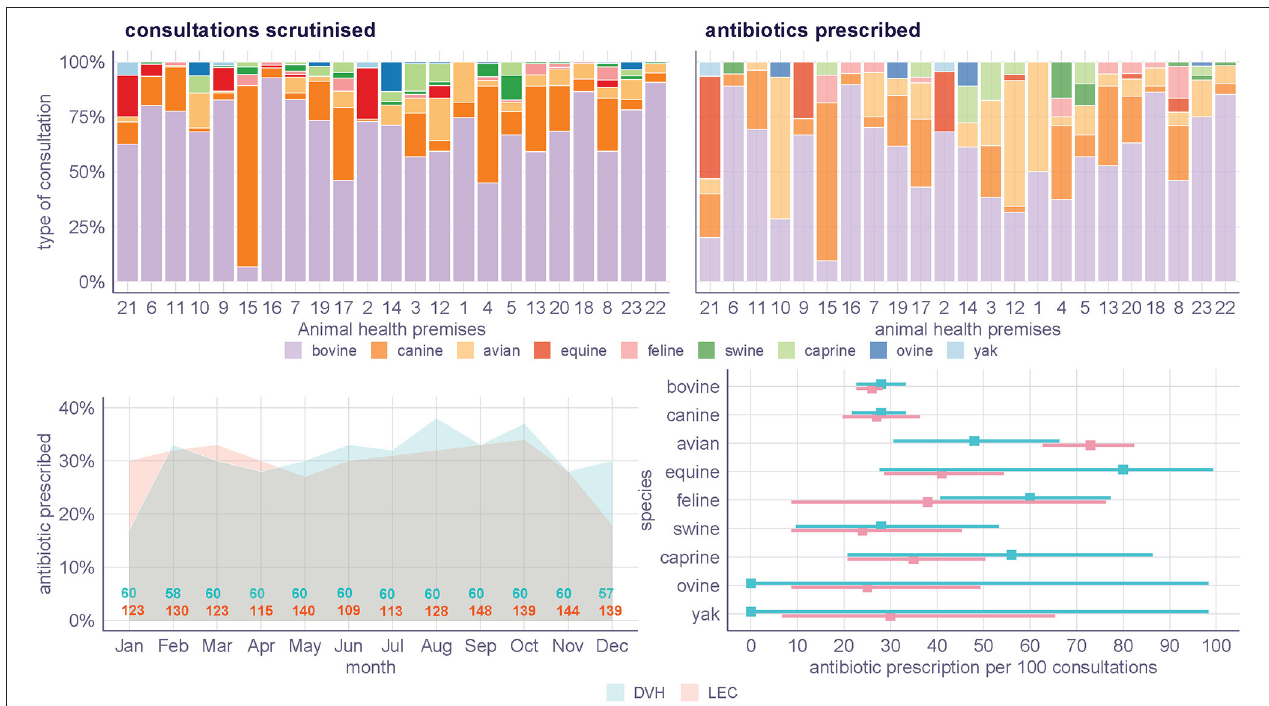
FIGURE 3 | Post-hoc analyses. Top, distribution of consultations per AHP (left) and distribution of consultations that resulted in at least one antibiotic prescribed (right, faded). Bottom: distribution of prescription across 2017 and the total number of records that inform each month (left). Incidence of antibiotic prescription (and 95% confidence interval) expressed as the number of veterinary consultations that resulted in an antibiotic prescription per 100 consultations in 2017 (right). LEC, livestock extension center; DVH, district veterinary